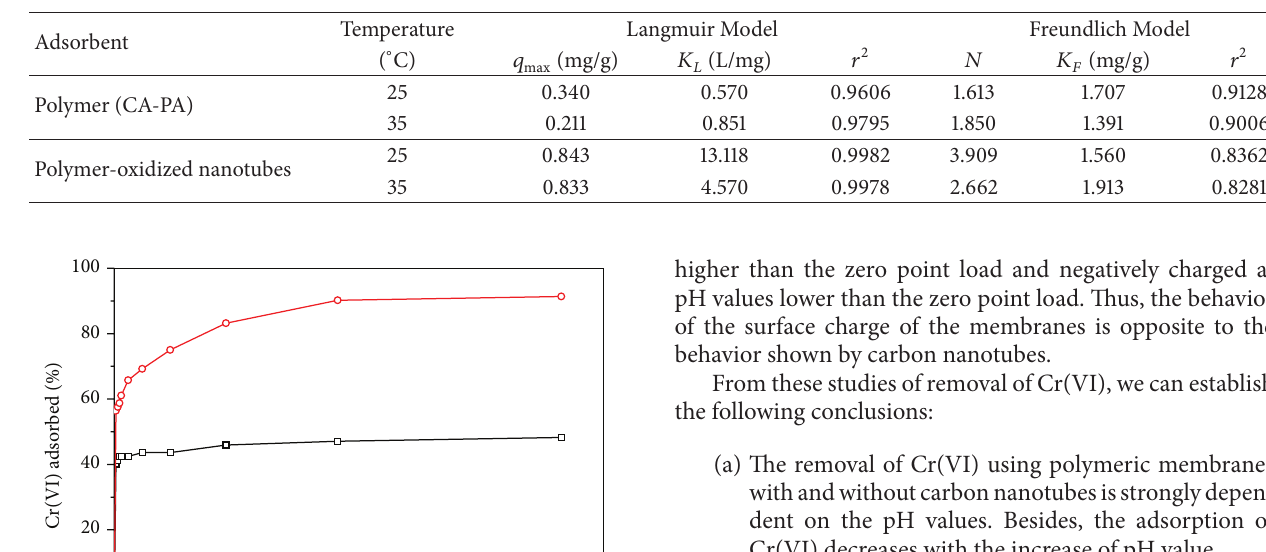
Table 3: Parameters of Langmuir Model and Freundlich Model.